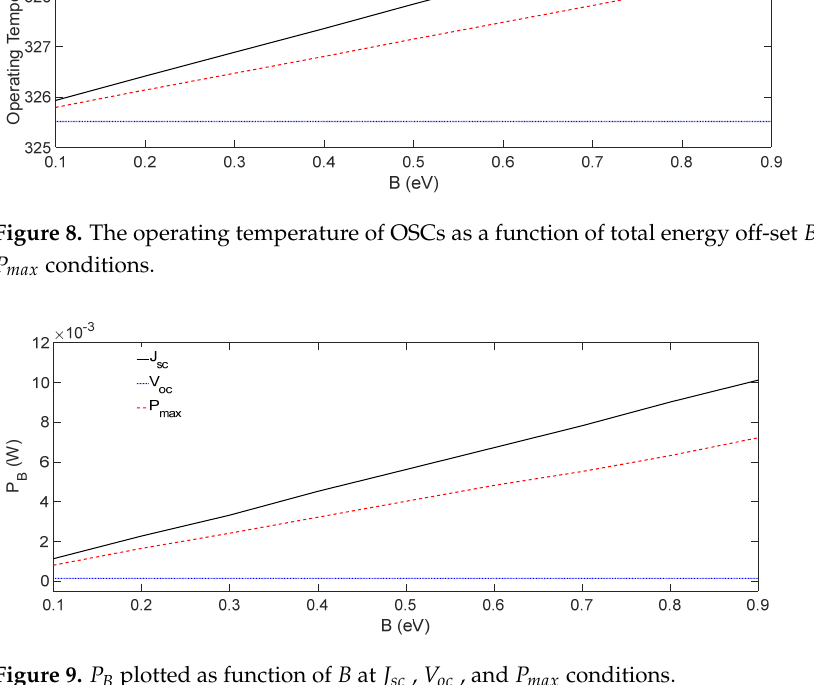
Figure 8. The operating temperature of OSCs as a function of total energy off-set 𝐵 at 𝐽 (cid:3046)(cid:3030) , 𝑉 (cid:3042)(cid:3030) , and 𝑃 (cid:3040)(cid:3028)(cid:3051) conditions.